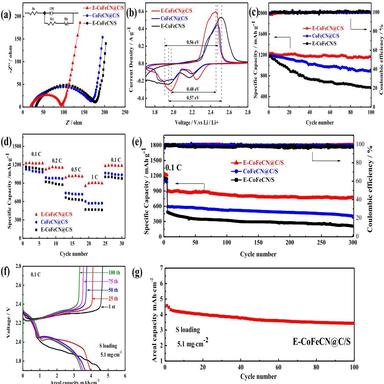
(a) EIS spectra, (b) CV curves, (c) Cycling at 0.1 C, (d) rate and (e) Cycling at 1 C of the E-CoFeCN@C/S, CoFeCN@C/S and E-CoFeCN/S cathodes. (f) Charge/discharge curves and (g) Cycling performance of the E-CoFeCN@C/S cathodes with the S loading 5.1 mg cm−2 at 0.1 C.